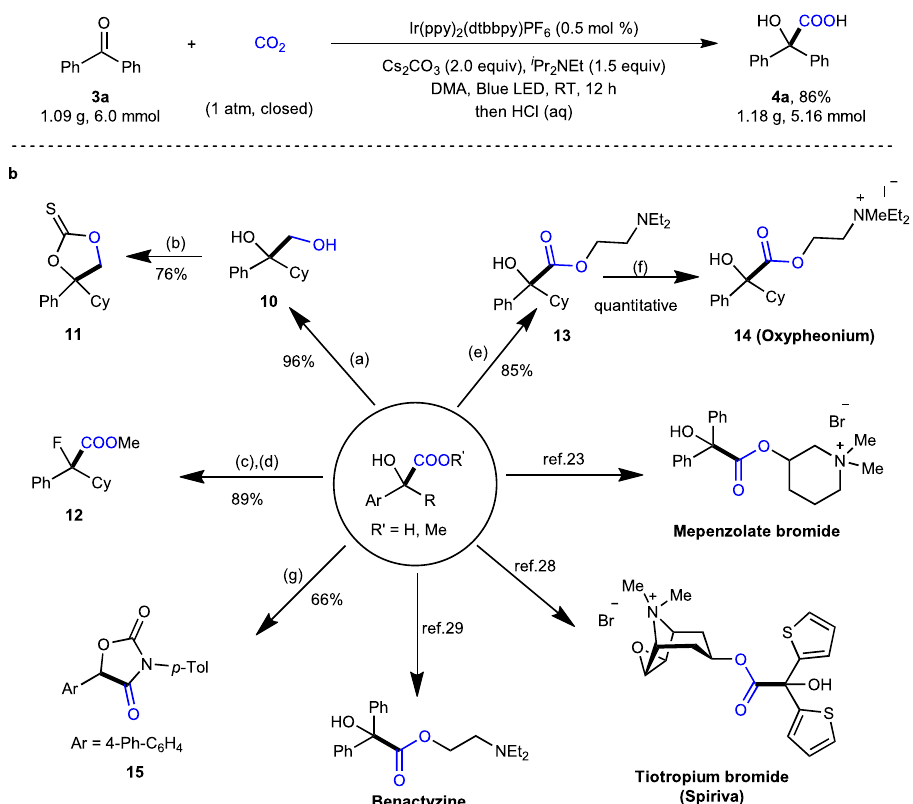
Fig. 10 Synthetic applications. a Gram-scale reaction. b Diverse functionalizations of products. (a) LiAlH 4 , THF, re fl ux. (b) TCDI, DCM, RT. (c) TMSCHN 2 , MeOH/Et 2 O; (d) Deoxo fl uor, DCM, RT, N 2 . (e) diethylamine, Na 2 CO 3 , DCE. (f) MeI, CH 3 CN, 65 °C. (g) p -Me-C 6 H 4 NCO, DMAP, THF, RT − 50 °C. TCDI = 1,1 ′ -Thiocarbonyldiimidazole. DCM dichloromethane, Deoxo fl uor Bis(2-methoxyethyl)aminosulfur tri fl uoride, DMAP N , N -dimethylpyridin-4-amine, THF